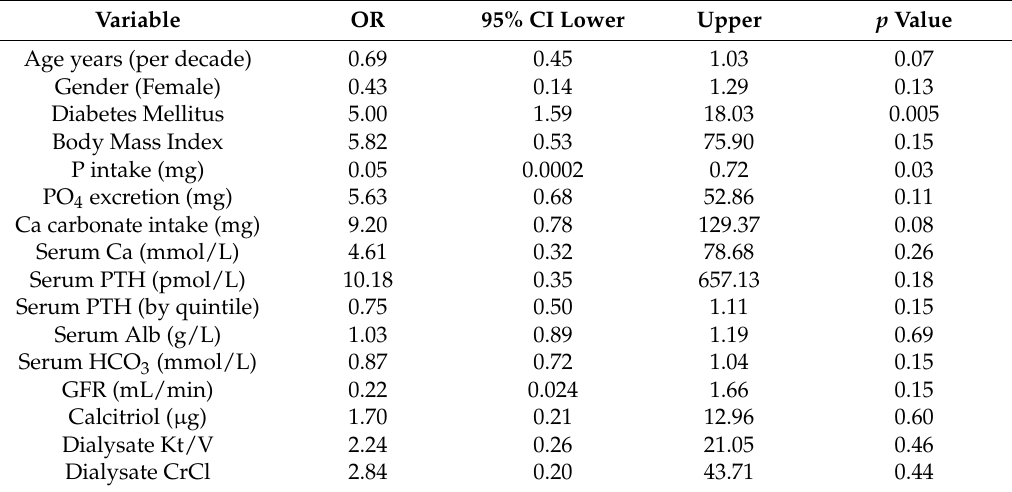
Table 2. Risk factors for a serum phosphate >1.78 mmol/L,